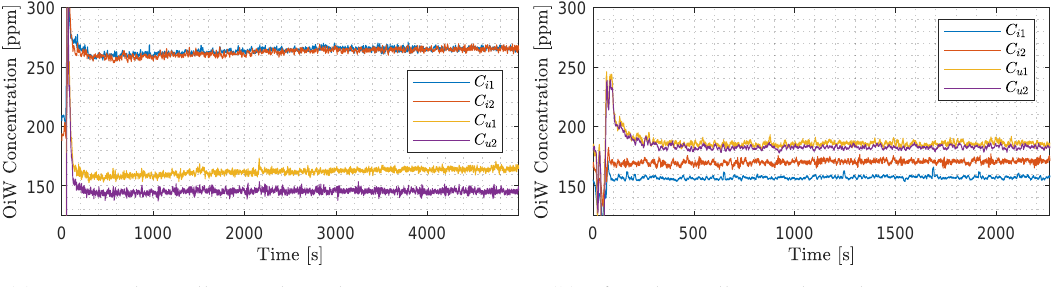
Figure 16. Concentration measurements doing no separation prior to and after physically switching the OiW monitors measuring C i 2 and C u 2 .